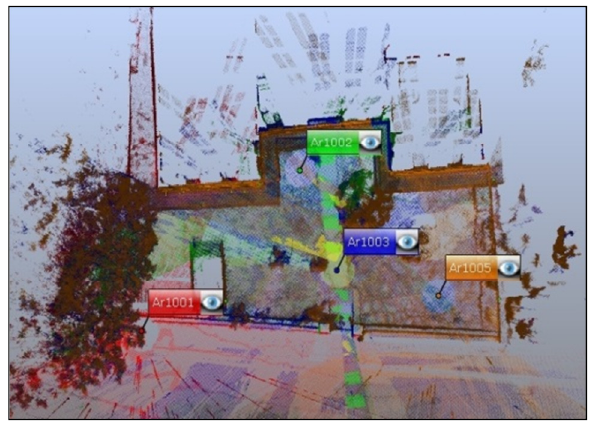
Figure 8. Scan locations in Skoutaris Mansion.